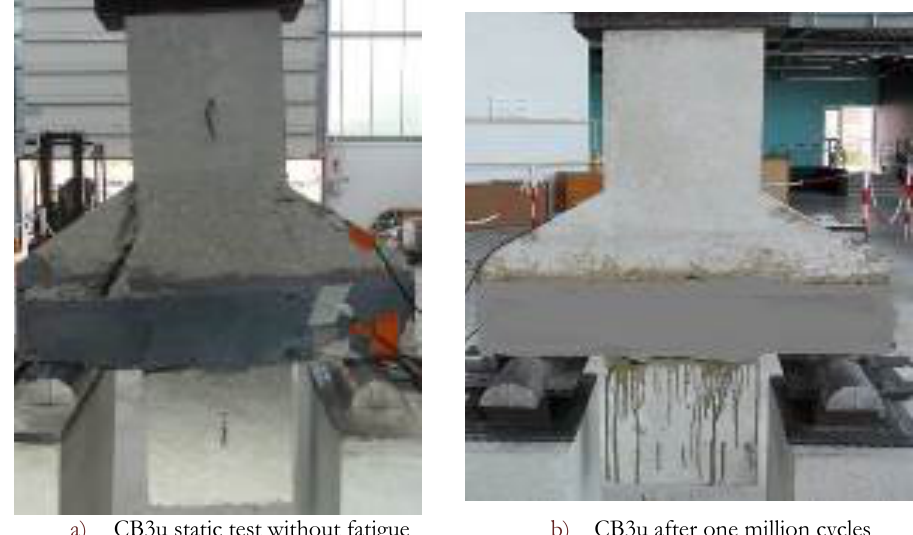
Figure 8: Cracking and failure in strengthened concrete corbel. a) CB3u-static loading to failure, b) CB3u -after one million